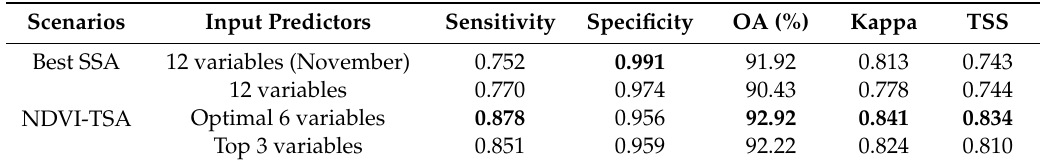
Table 6. Classification accuracies of the two scenarios, using the EOCC algorithm. The best result of each accuracy metric is shown in bold.